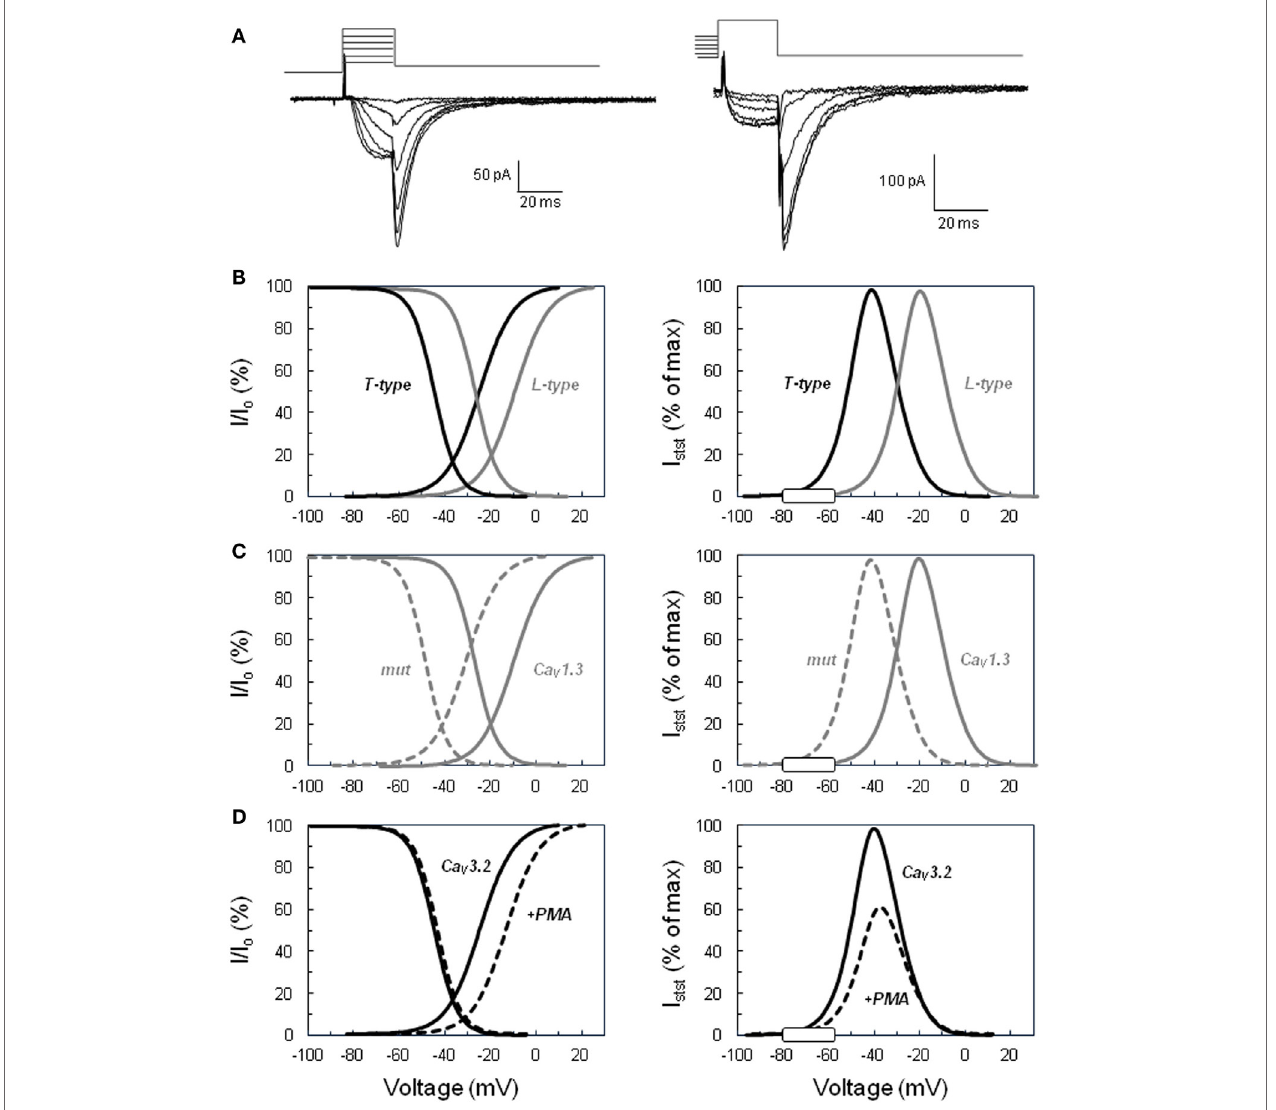
FiGURe 1 | Activation and inactivation of voltage-operated calcium channels and steady-state “window” currents . (A) Examples of slowly deactivating (T-type) Ba 2 + currents recorded in the whole cell configuration of the patch clamp technique. Left. Voltage protocol for determining the activation curve: tail currents were evoked by repolarizing the cell to − 65 mV after a short period (20 ms) of depolarization at various voltages ( − 45 to + 5 mV for this selection of traces) from a holding potential of − 90 mV. Right. Voltage protocol for determining the steady-state inactivation curve: tail currents were elicited in the same cell at − 65 mV, but after steady-state inactivation of the channels for 10 s at various holding potentials (here from − 80 to − 30 mV) and 20 ms activation at + 20 mV. Current amplitude upon cell repolarization was then determined by fitting tail currents to an exponential function (the time constant was approximately 7 ms). (B) Comparison of low (T-type) versus high (L-type) threshold voltage-operated calcium channels. Left panel shows normalized activation and inactivation curves determined for T-type channels using the same type of protocol as shown in panel A. Tail current amplitudes were plotted as a function of the test voltage, fitted to Boltzmann’s equation, and normalized to the maximal current ( I o ). Curves for L-type channels were similarly defined from L-current amplitudes determined with a different voltage protocol, including the inactivation of T currents. Right panel displays the calculated normalized steady-state current ( I stst ) expected through T-type and L-type channels within their respective permissive window of voltage. The theoretical steady-state currents were obtained from the activation and inactivation curves according to Ohm’s law and expressed as a percentage of the maximal current. The white rectangle on the voltage axis indicates the range of membrane potentials reached in naive glomerulosa cells and in cells stimulated with physiological concentrations of angiotensin II or extracellular potassium. (C) Effect of the Ile770Met mutation described in the CACNA1D L-type calcium channel (13) on the channel activation, inactivation, and steady-state current. Curves have been determined as in (B) for the wild-type channel (continuous line, Ca V 1.3) and for the mutant channel (dotted line, mut) and show the significant shift of the channel permissive window toward lower voltages. (D) Effect of PKC activation on CACNA1H T channel activation, inactivation, and steady-state current. Curves have been determined as in (B) for the naive channel (continuous line, Ca V 3.2) and for the channel in glomerulosa cells treated with the PKC activator phorbol 12 myristate 13-acetate ester (dotted line, + PMA) and show the significant reduction of the amplitude of the maximal steady-state current with the slight shift of the permissive window toward higher voltages. The graphs of this figure have been constructed based on data available in Ref. (14, 13).